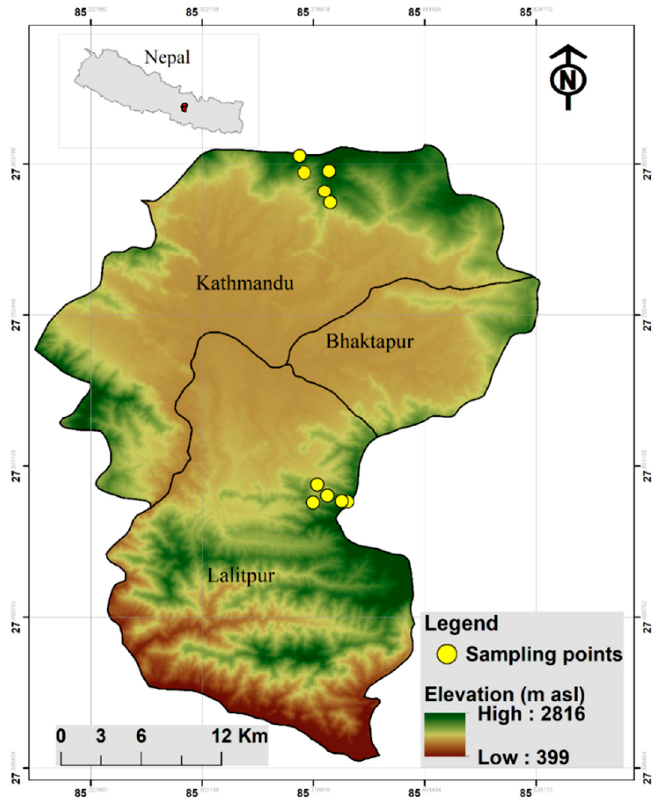
Figure 1. Map showing the locations of the areas in the Kathmandu valley, central Nepal, that were studied.